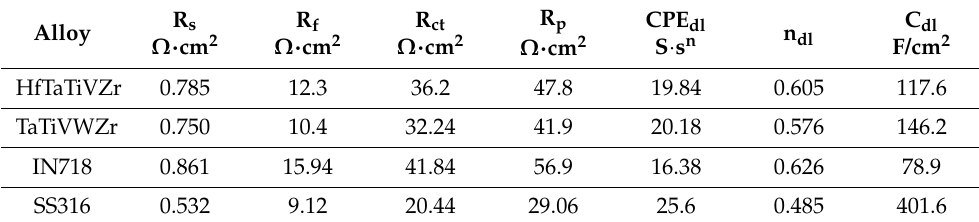
Table 1. Equivalent circuit parameters from EIS study in molten FLiNaK salt at 650 ◦ C.